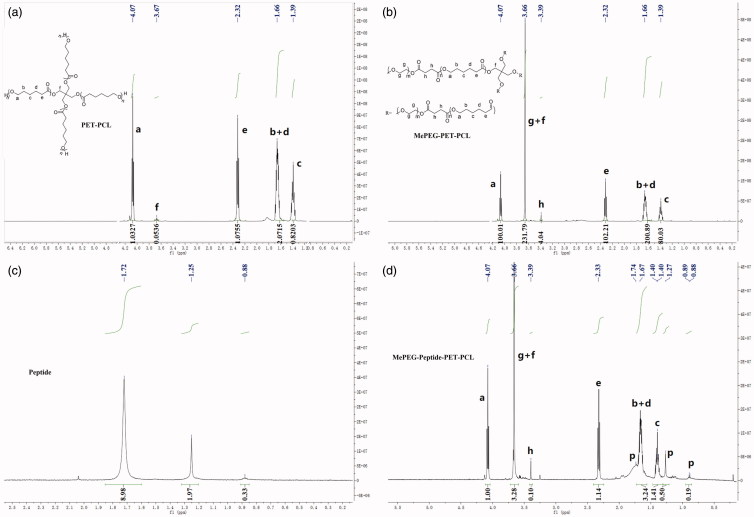
1H-NMR spectra of PET-PCL, MePEG-PET-PCL, peptide, and
MePEG-peptide-PET-PCL.